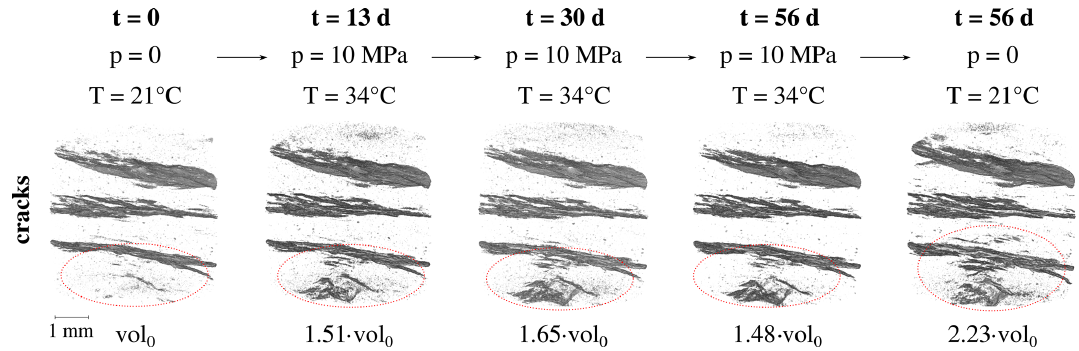
Figure 9. Evolution of pre-existing fissures and appearance of new ones (encircled zones) after direct exposure to supercritical CO 2 (illus- tration in